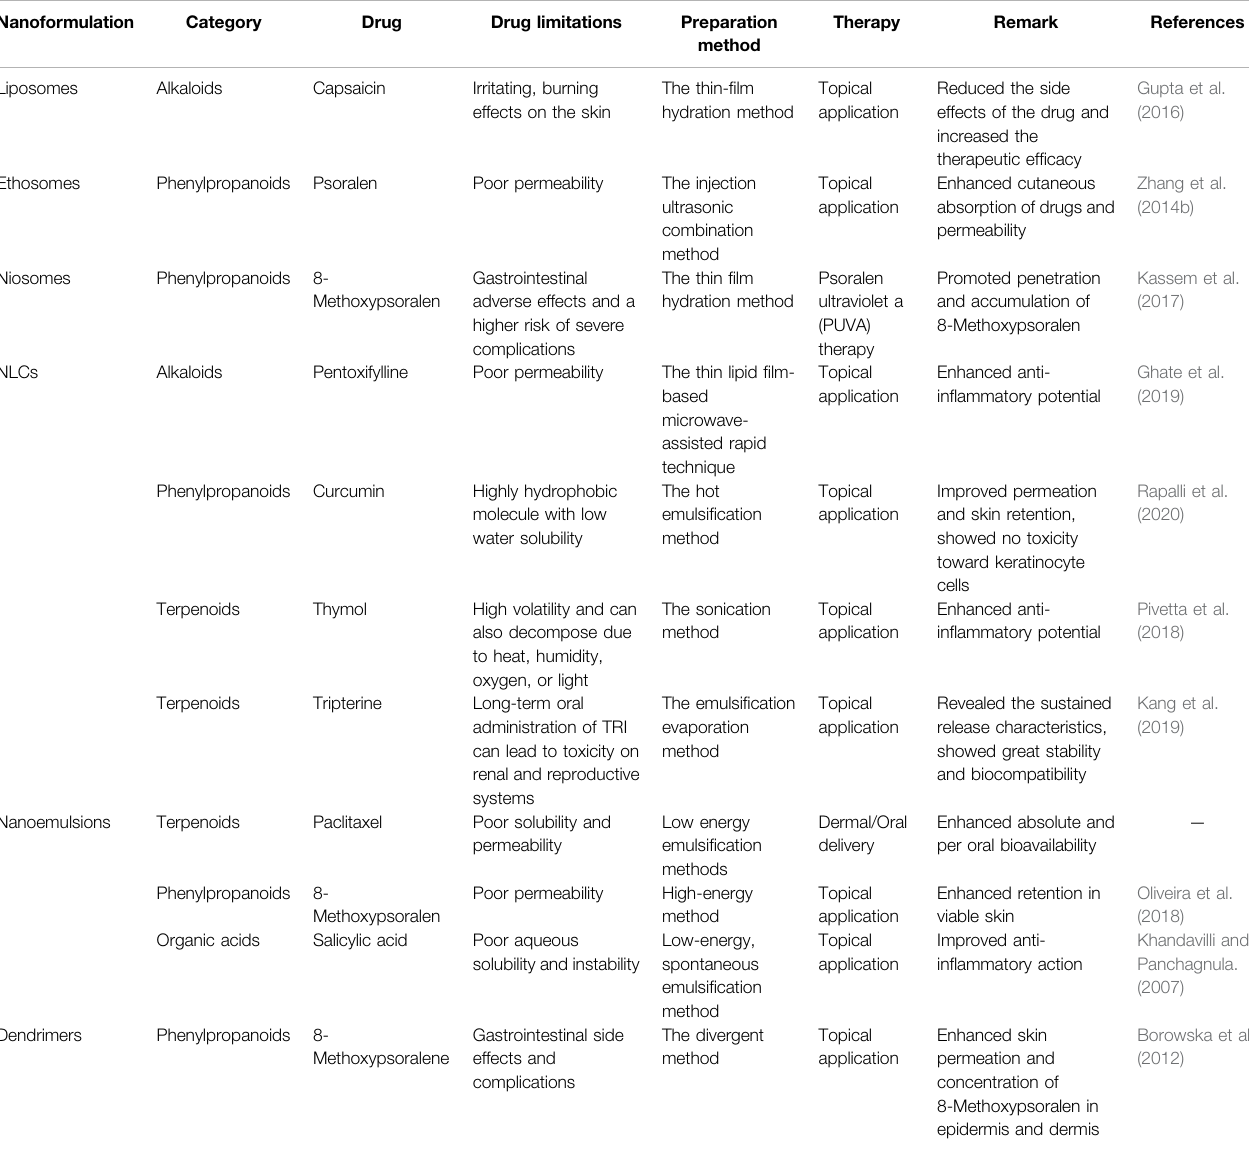
TABLE 5 | Nanoformulation-based natural products for the treatment of psoriasis.